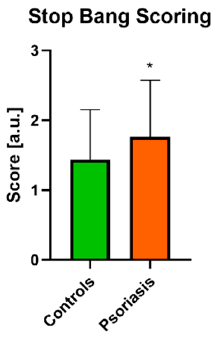
Figure 4. Assessment of risk of OSAS in psoriatics and control groups . The graph presents data shown as Mean ± SD and values are normally distributed. *—means the existence of a statistically significant difference between values treatment with p < 0.05. OSAS, obstructive sleep apnea syndrome. Data are shown as Mean ± SD or Contingency Graph.